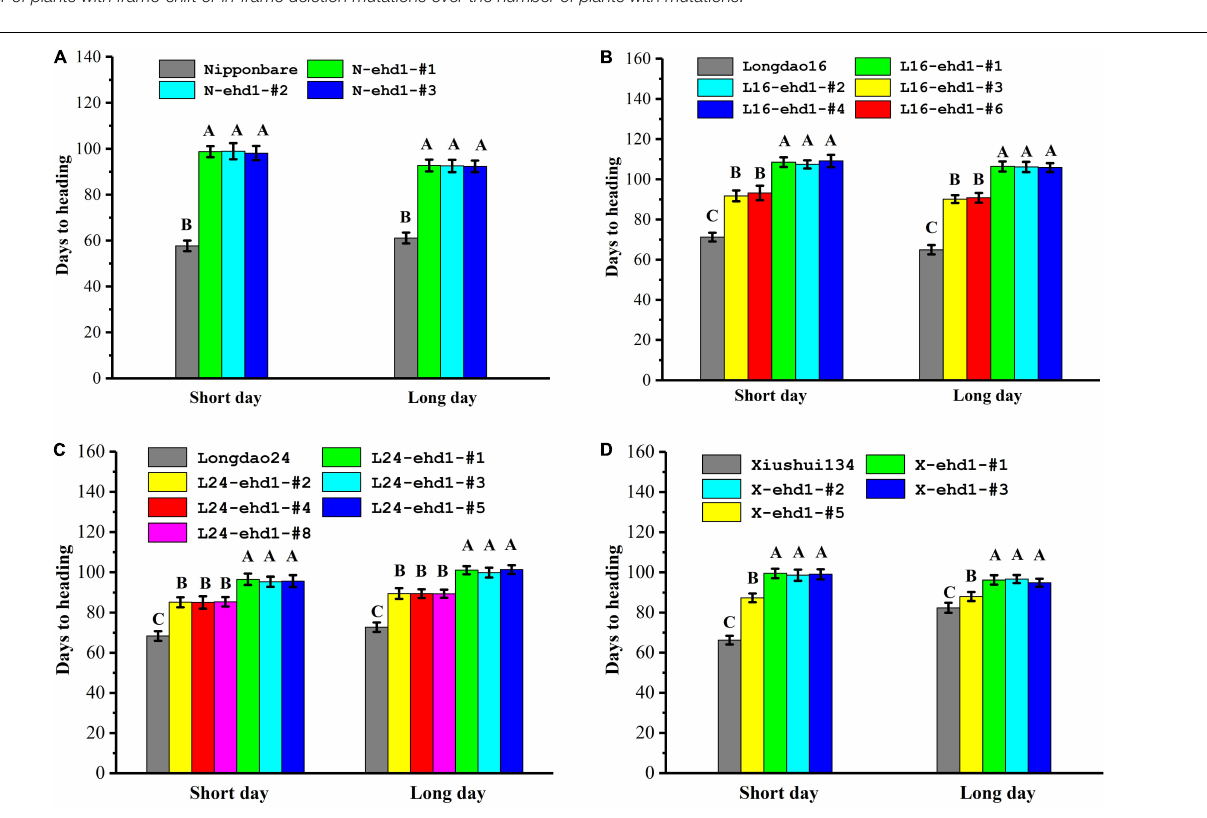
FIGURE 2 | ehd1 mutant lines exhibited prolonged basic vegetative growth (BVG) periods under short day and long day conditions. Rice plants were cultivated at Sanya experimental station under nature short day condition (December to next April, c. 11–12.5 h, 18 ◦ 14 (cid:48) N, 109 ◦ 31 (cid:48) E), and at Fuzhou experimental station under natural long day condition (mid-May to mid-September, c. 13.5 h, 26 ◦ 08 (cid:48) N, 119 ◦ 28 (cid:48) E). (A–D) Flowering times of homozygous mutant lines in Nipponbare (A) , Longdao16 (B) , Longdao24 (C) and Xiushui134 (D) backgrounds under both short day and long day conditions. Data were collected from 30 plants. The letters A, B, and C indicate significant differences according to LSD multiple range test at P ≤